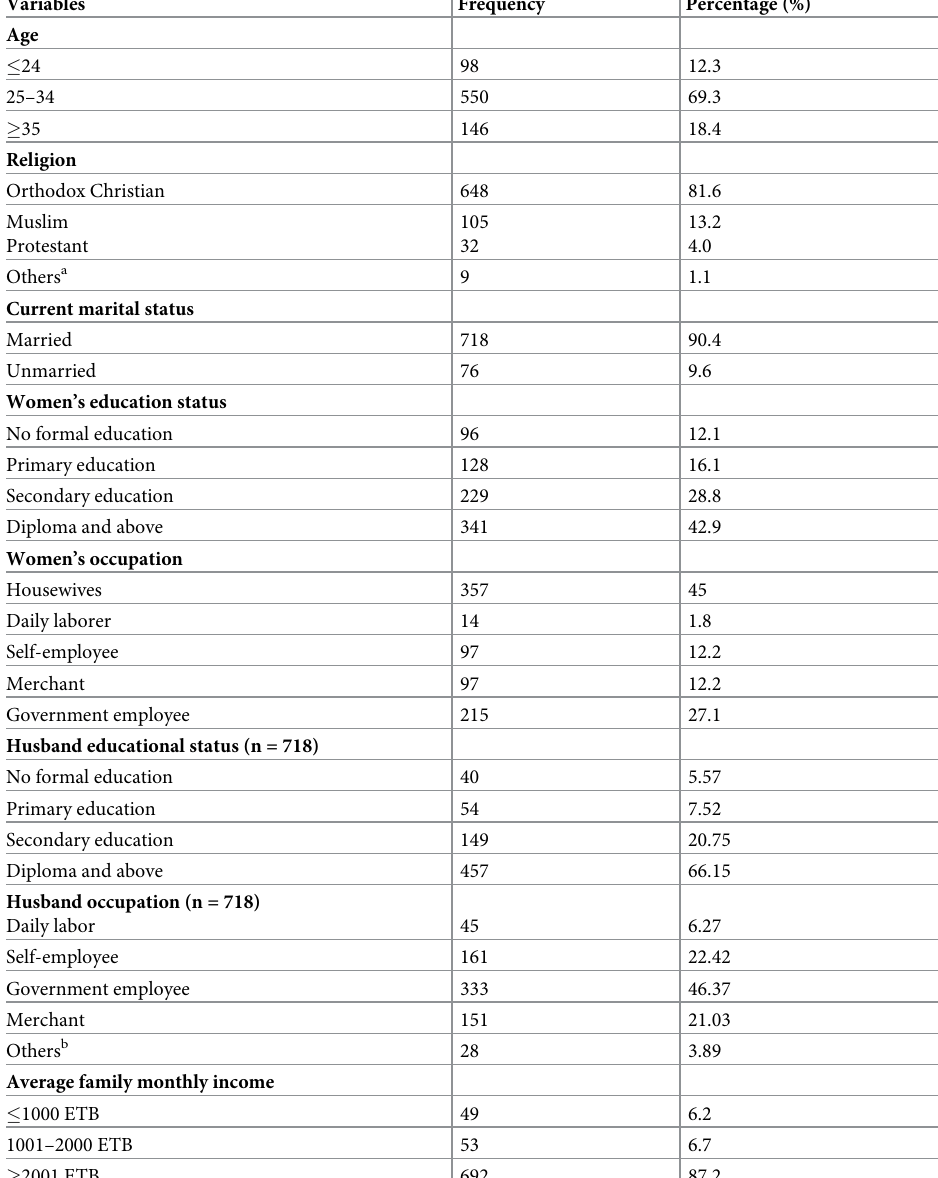
Table 1. Socio-demographic characteristics of women who gave birth in the last one year in Gondar city, North- west Ethiopia, 2021 (n = 794). Variables Frequency Percentage